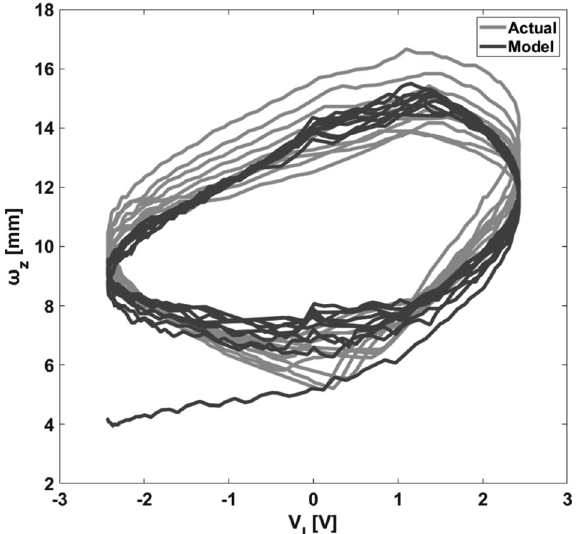
Figure 8. Displacement vs. voltage state-trajectory of chirp dataset.